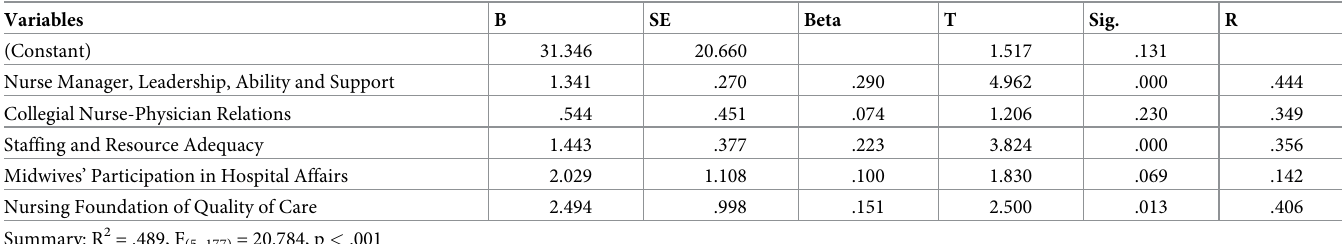
Table 4. Predictors of midwives’ job